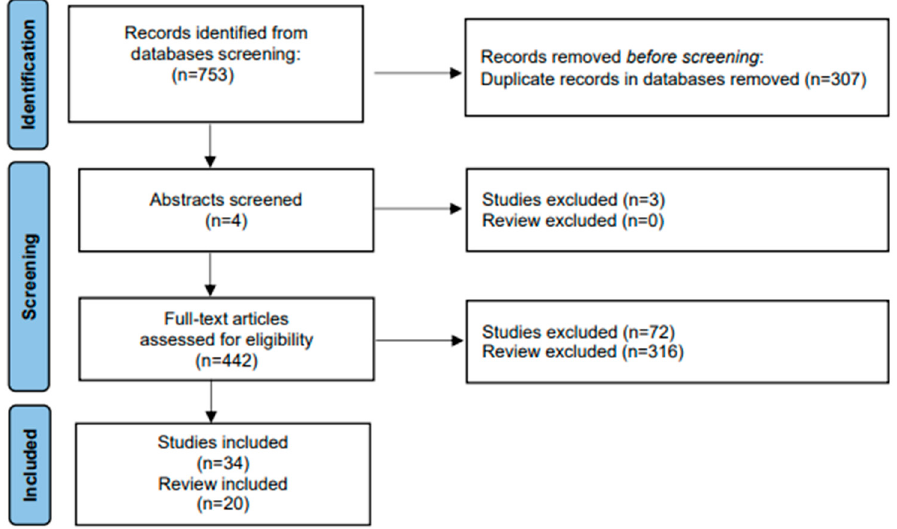
Figure 1. Flow chart related to the selection methodology of the studies included in the review.